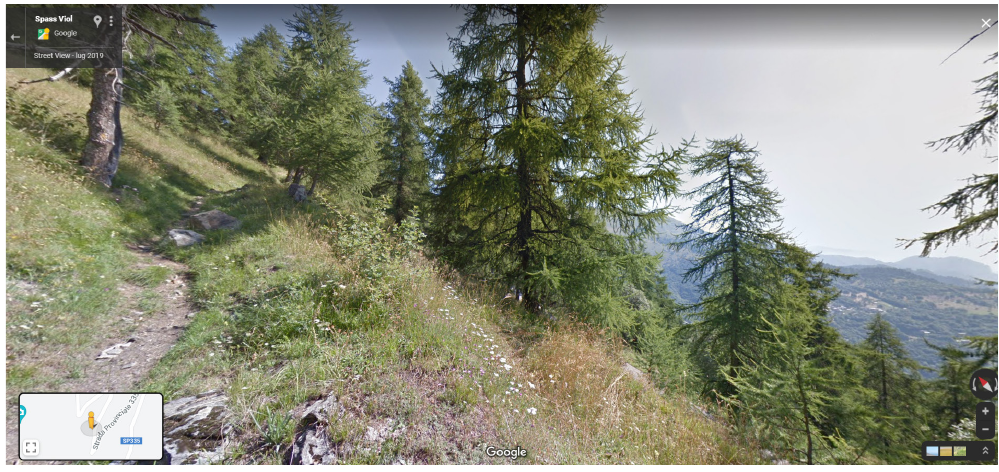
Fig. 4 Percorsi Occitani available in Google Street